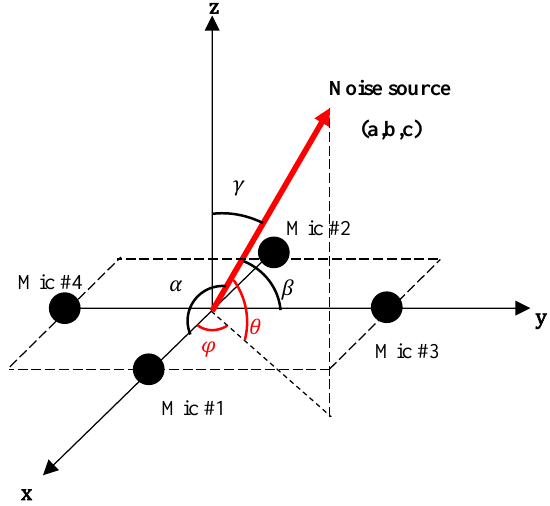
Figure 8. Direction angles in the local Cartesian coordinate.